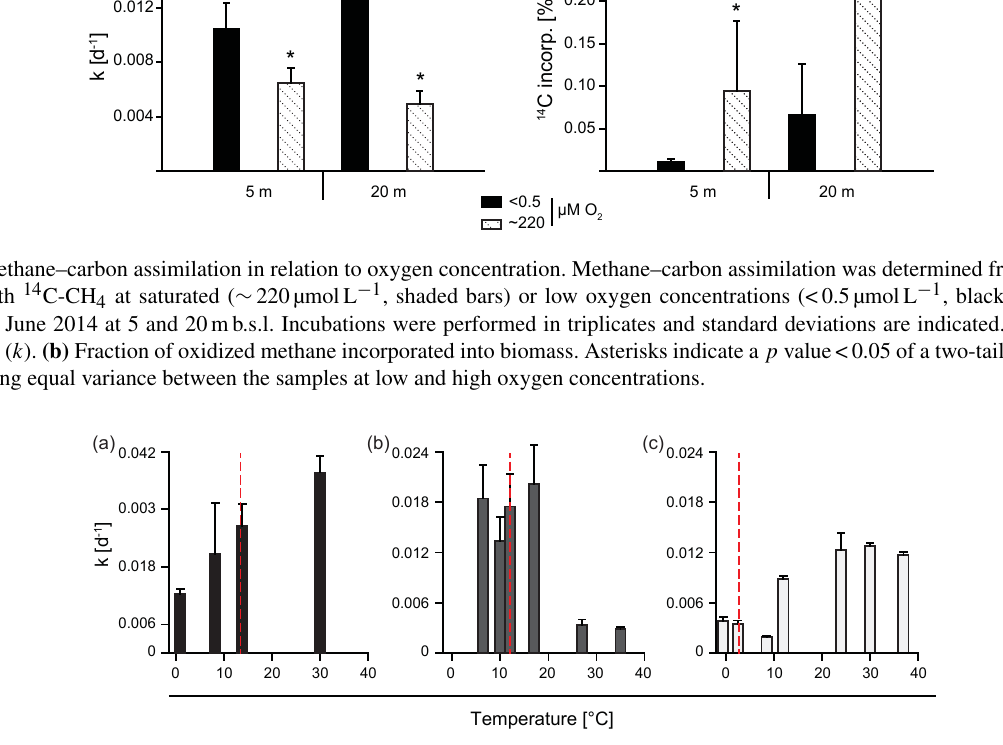
Figure 5. MOx first-order rate constants ( k ) at different temperatures. First-order rate constants of MOx were determined with 3 H-CH 4 amendments in triplicated incubations of water from 20mb.s.l. recovered in September 2013 (a) , November 2013 (b) , and February 2014 (c) . Red, dashed lines indicate in situ